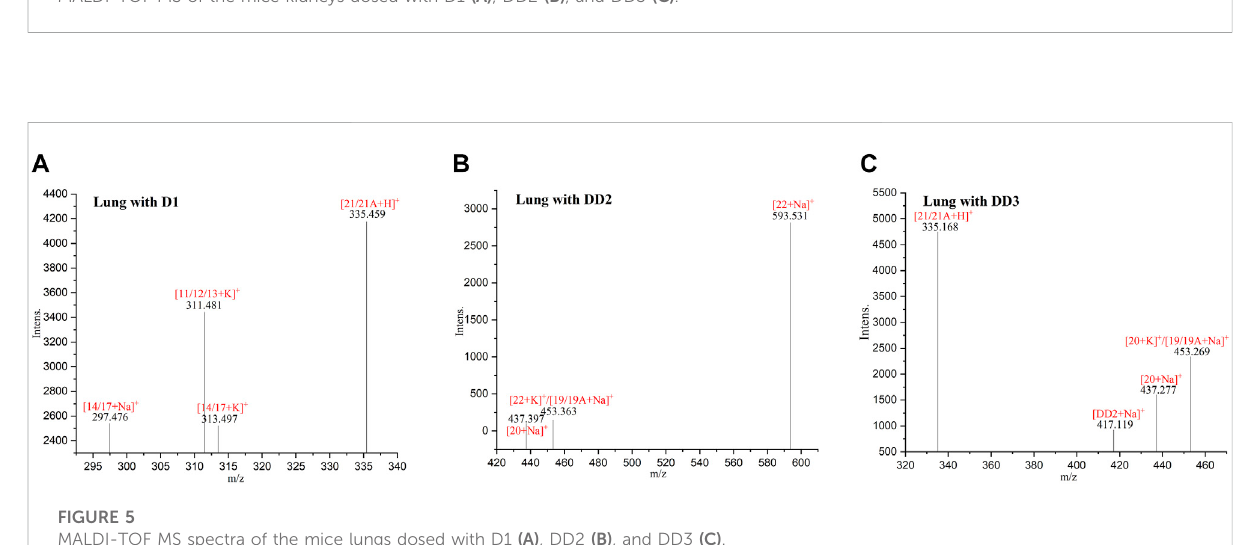
FIGURE 4 MALDI-TOF MS of the mice kidneys dosed with D1 (A) , DD2 (B) , and DD3 (C) .